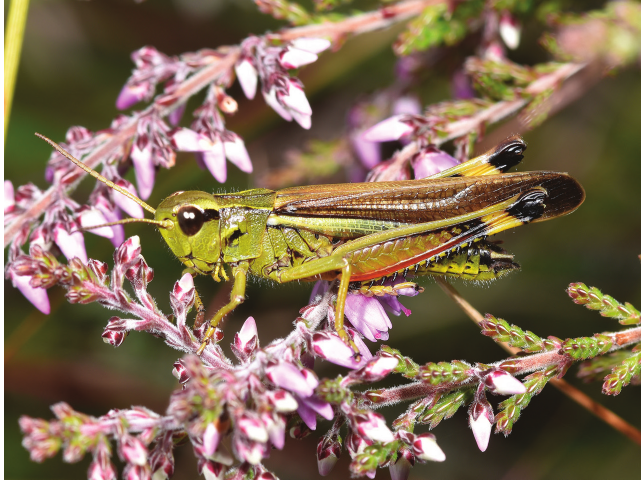
Fig. 2. Male Stethophyma grossum ; credit P. Brock.